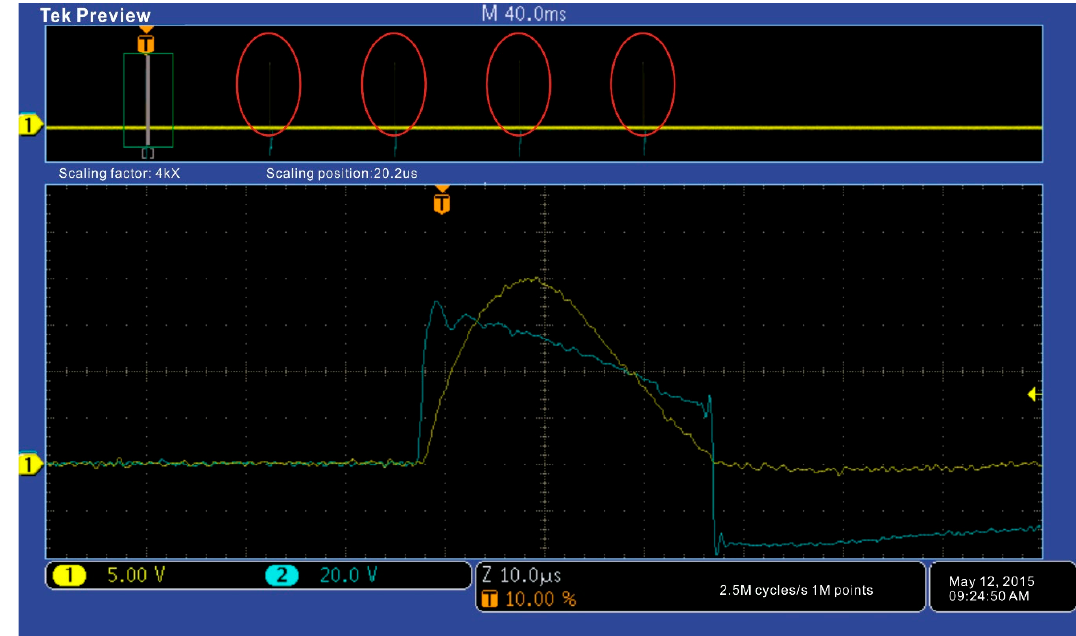
Figure 14. Current and voltage waveforms under five pulses.